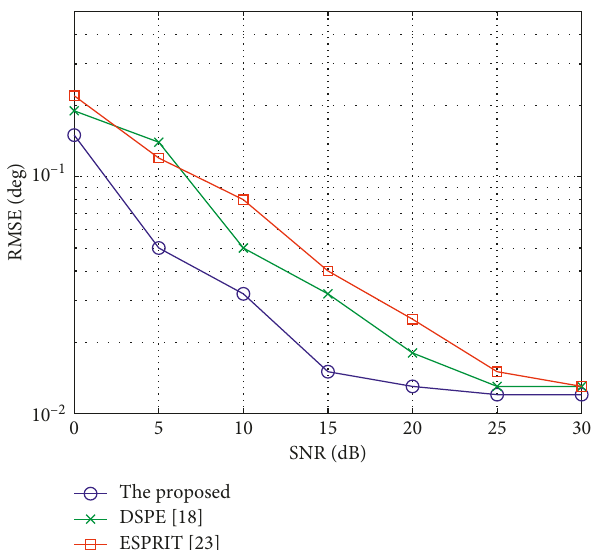
Figure 3: RMSE estimated by three methods for 2D CD sources uncorrelated with each other.